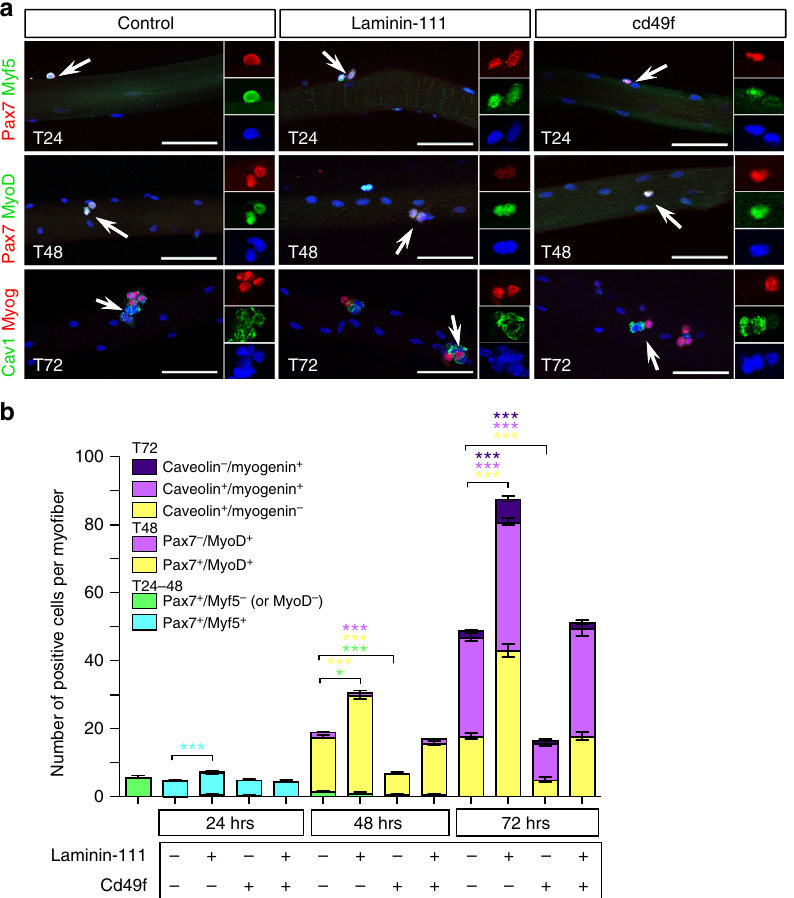
Fig. 7 Laminin-111 treatment increases SC proliferation and self-renewal. a Representative images of myo fi bers cultured in control conditions or in the presence of laminin-111 or Cd49f, and analyzed by immuno fl uorescence for Pax7 (red), Myf5 (green), MyoD (green), Caveolin-1 (green), and Myogenin (red). Scale bar: 50 μ m. b Quanti fi cation of satellite cell populations in myo fi ber cultures supplemented with Laminin-111, Cd49f, or both. Graph